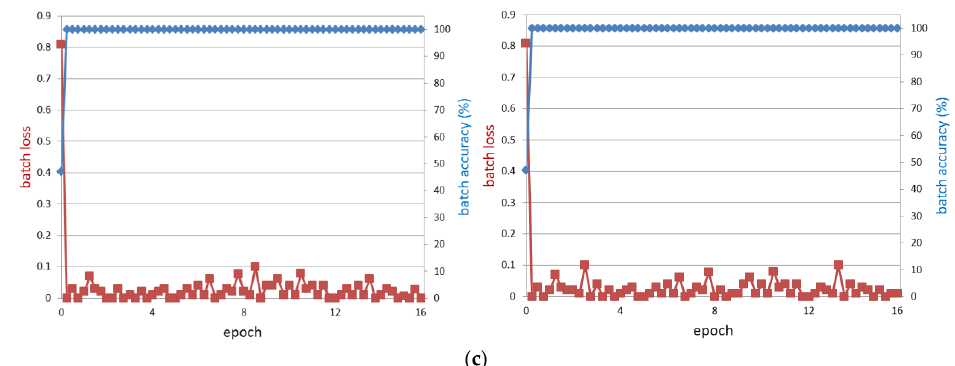
Figure 12. The curves of training loss and training accuracies according to the number of epoch with the sub-databases of ( a ) face; ( b ) left eye; and ( c ) right eye. In ( a – c ), left and right figures respectively show the graphs from the training of first- and second-fold cross validations.